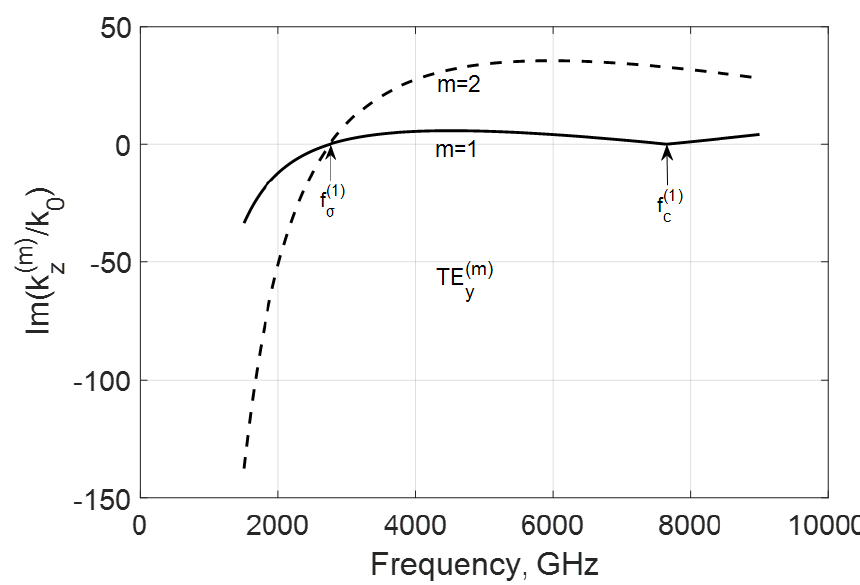
(cid:19) (cid:18) ( m ) ( m ) k of the first two TE y z / k 0